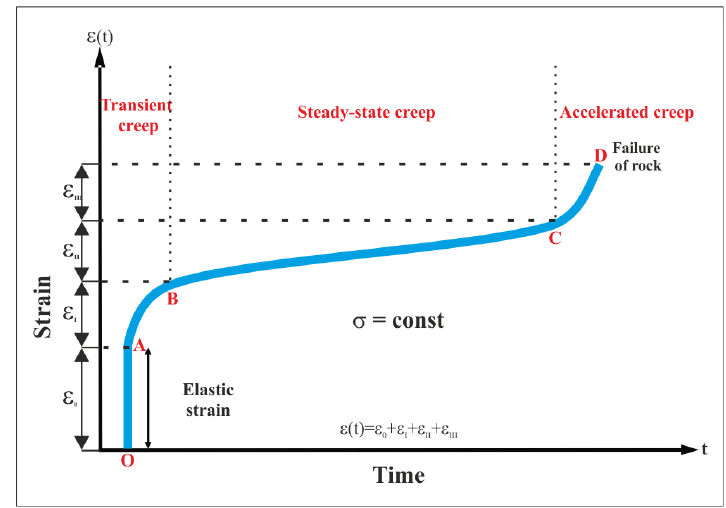
Figure 1. Schematic diagram of the creep process [20], modified.